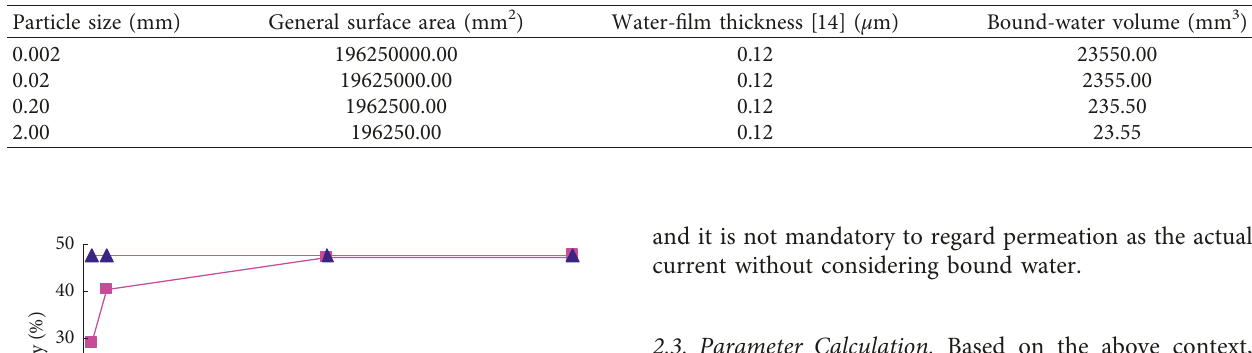
Figure 2: Specific surface areas for different soil particles with particle sizes of (a) 0.002mm and 0.02mm and (b) 0.2mm and 2.0mm. Table 1: Bound-water volumes for different soil particles.